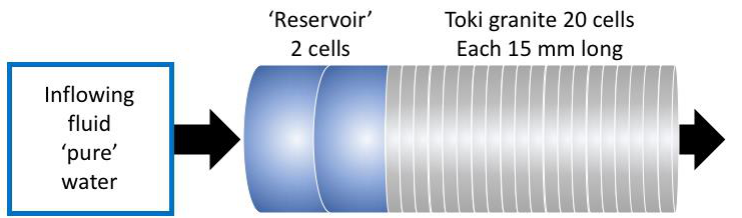
Figure 3. Geometry of the experimental setup as represented in CABARET. The 2-cell ‘Reservoir’ represents the single physical fluid reservoir, with the granite divided into 20 sections, each 15 mm long and 7.5 mm in diameter (note: not to scale).